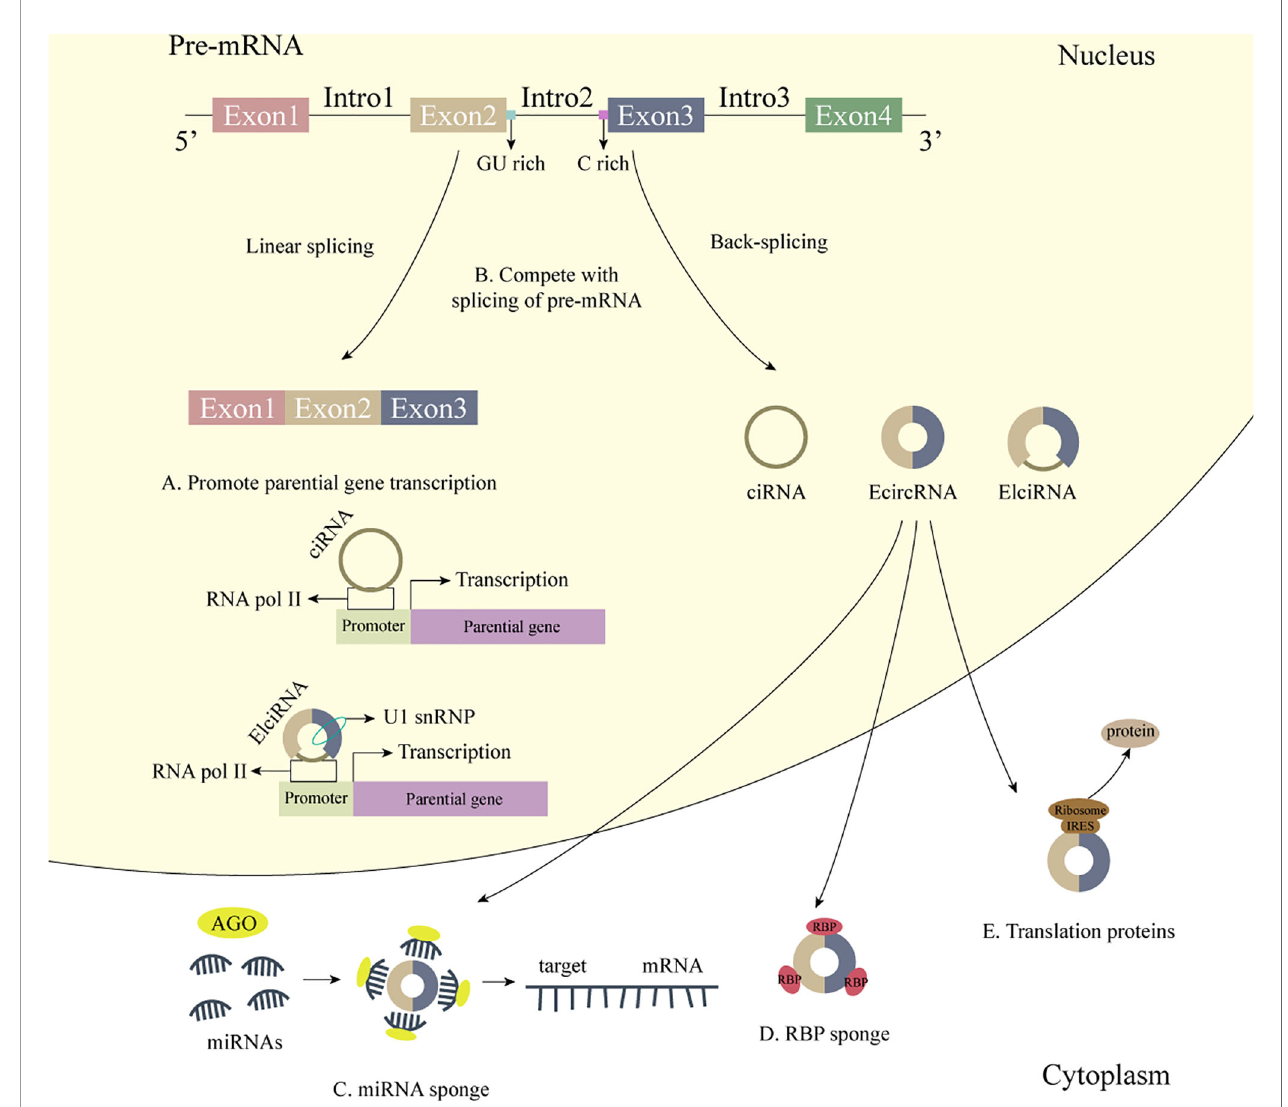
FIGURE 1 | The biogenesis and biological functions of circRNA. 1) The biogenesis of circRNA. CircRNAs are exon or intron sequences spliced in reverse from the pre-mRNA. 2) Some biological functions of circRNA. (A) CiRNAs interact with RNA Pol II, and EIciRNAs interact with RNA Pol II and U1 snRNP and further promote the transcription of their parental genes. (B) CircRNAs affect the selective splicing of pre-mRNA. (C) CircRNAs act as miRNA sponge. (D) CircRNAs act as RBP sponge. (E) CircRNAs bind to IRES to generate functional